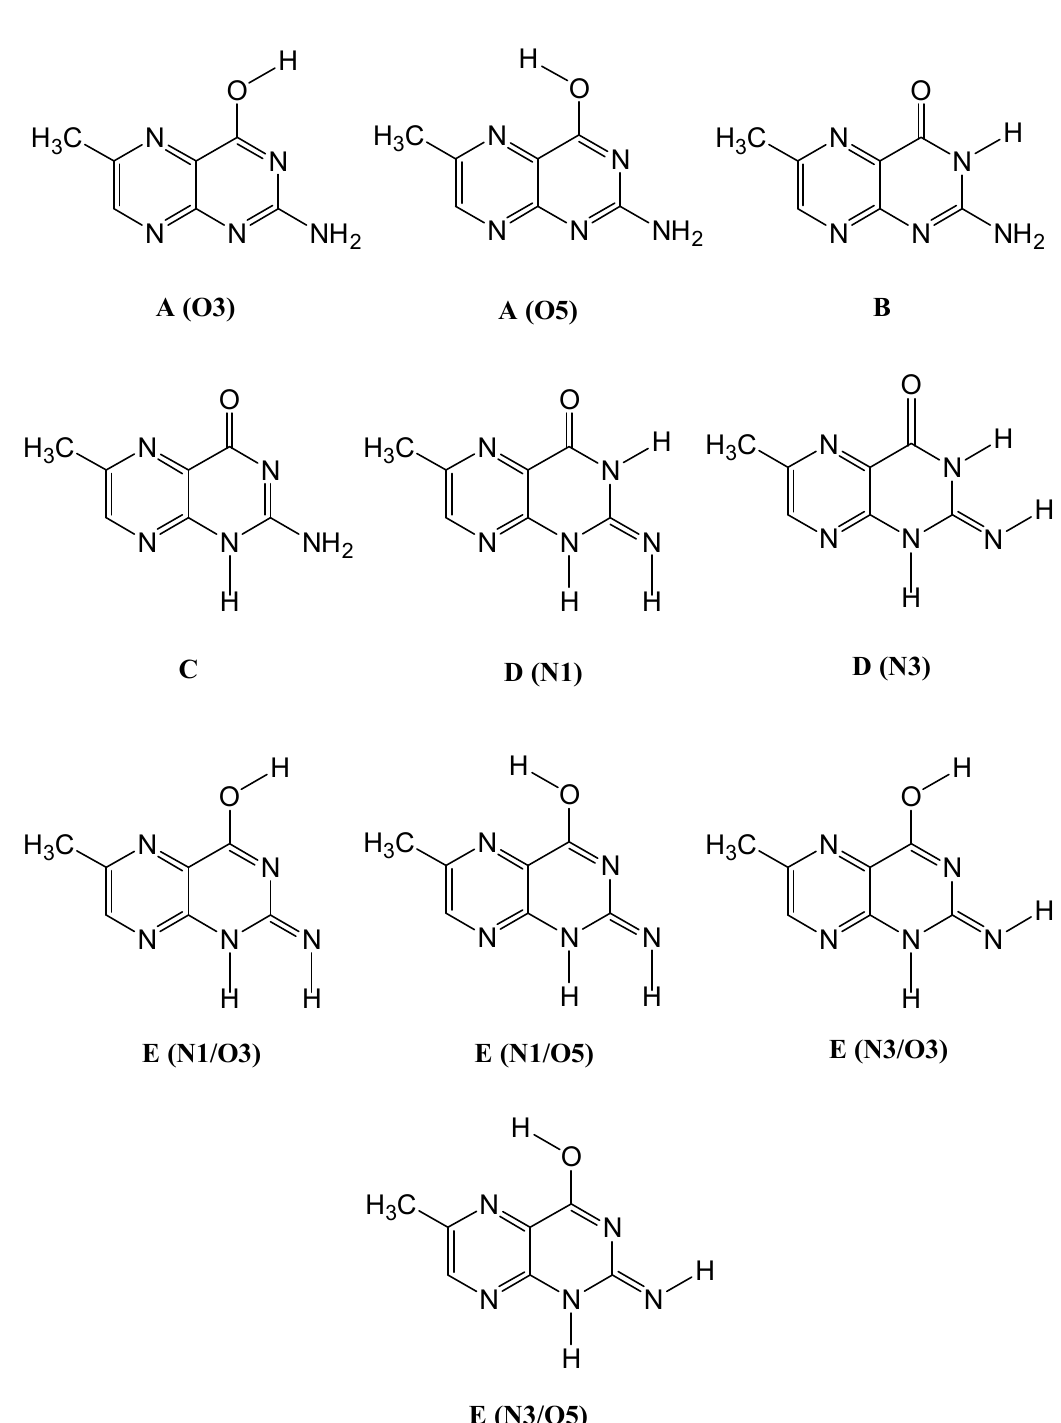
Figure 2: Tautomers of pterins used in present study using B3LYP level of theory with 3-21G ∗ , 6-31G ∗ , and 6- 31G ∗∗ basis